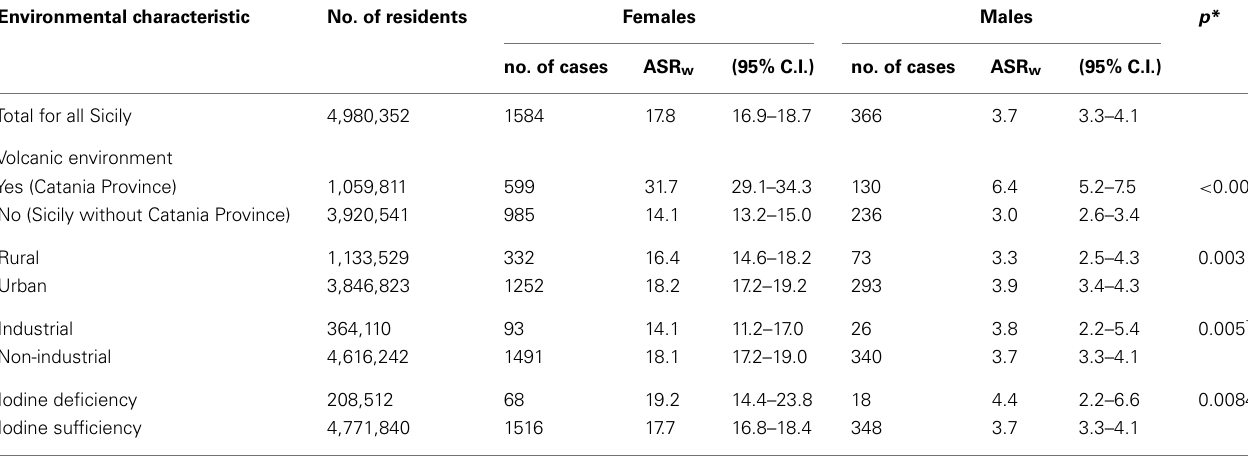
Table 2 |Thyroid cancer incidence in Sicily: age-standardized rates for the world population (ASR w ) for the entire island and by environmental